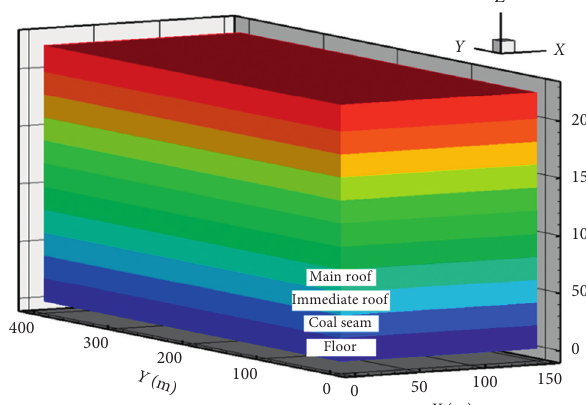
Figure 8: Original